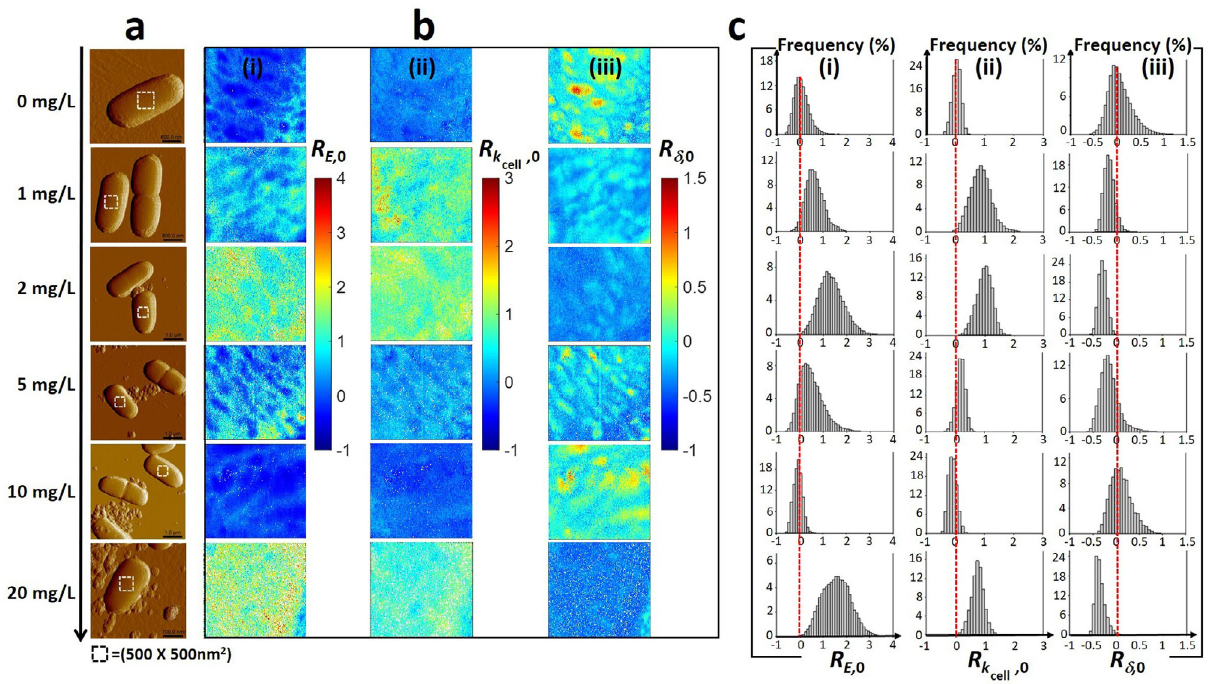
Fig. 6 Multiparametric AFM evidences TiO 2 NP-mediated changes in cell surface elasticity and Turgor pressure for JW3606 (hep + ) with increasing TiO 2 NP concentration. a Illustrative AFM de fl ection images of JW3606 (hep + ) after 20 h co-incubation with TiO 2 NPs of various concentrations (indicated). The white boxes de fi ne the 500 × 500 nm 2 cell surface areas where 65,536 force curve measurements were carried out. b Corresponding spatial maps of (i) Young modulus E , (ii) cell stiffness k cell , and (iii) indentation δ expressed in terms of R E ; details). c Histogram-distributions of R E ; 0 , R k , and R δ ; 0 corresponding to the maps given in ( b ). Red dotted lines in ( c ) are only guides to the cell ; 0